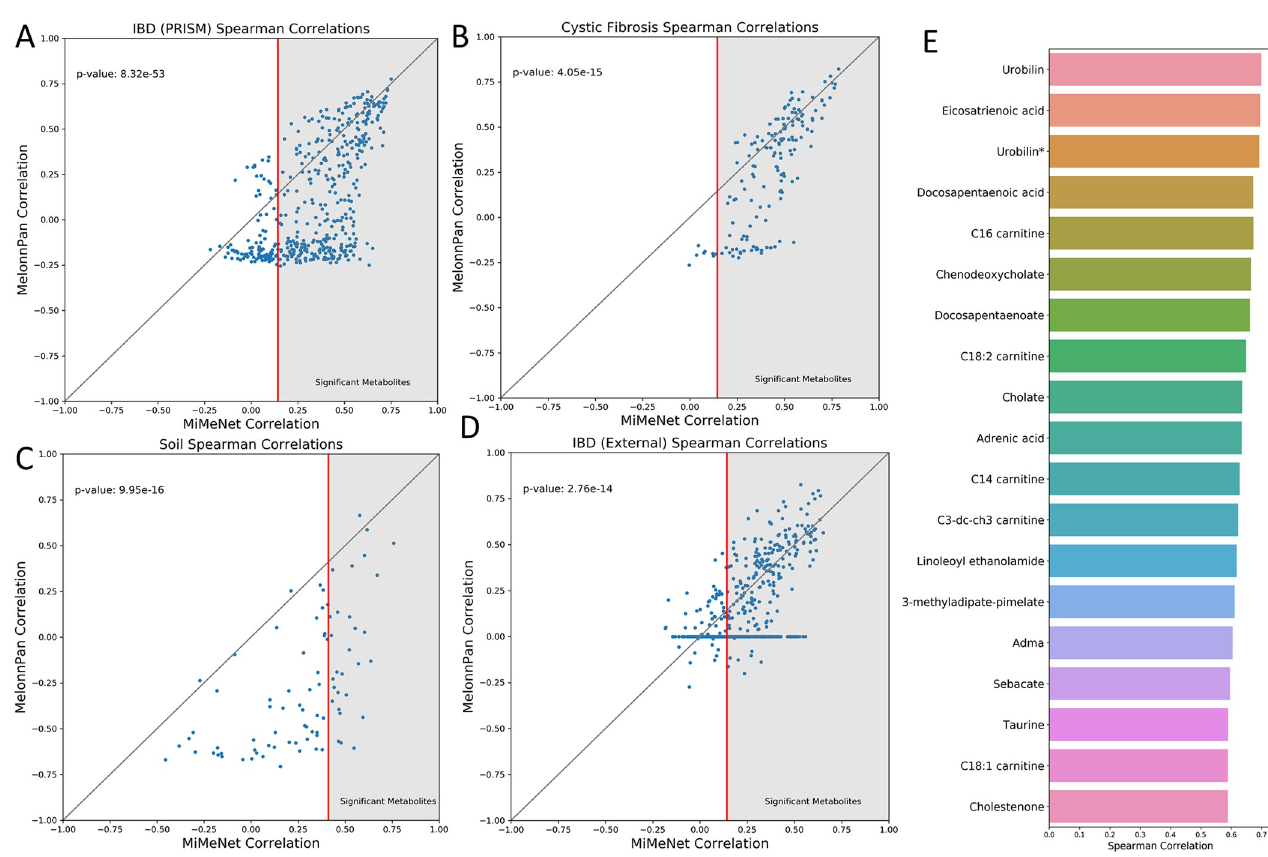
Fig 4. Scatter plots comparing MiMeNet to MelonnPan prediction correlations. Scatter plots showing the metabolite prediction correlations of MiMeNet against MelonnPan for (A) PRISM IBD dataset, (B) cystic fibrosis dataset, and (C) soil dataset, each trained using 10 iterations of 10-fold cross-validation. (D) In addition, 10 iterations of both models were trained on the PRISM dataset to evaluate the external IBD dataset. Each point represents the average correlation of a metabolite across 10 iterations of training. (E) The top 20 best correlated metabolites identified from the PRISM IBD dataset are